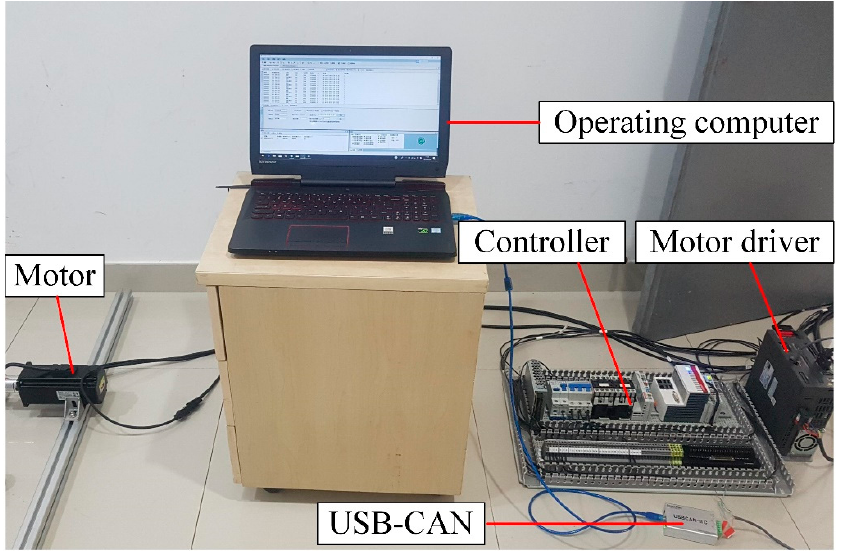
Figure 10. The motor driving system.